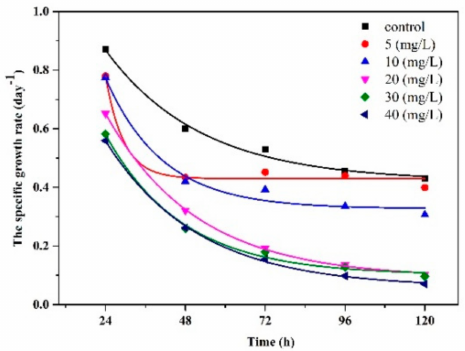
Figure 6. Growth curves of Chlorella vulgaris with different concentrations of